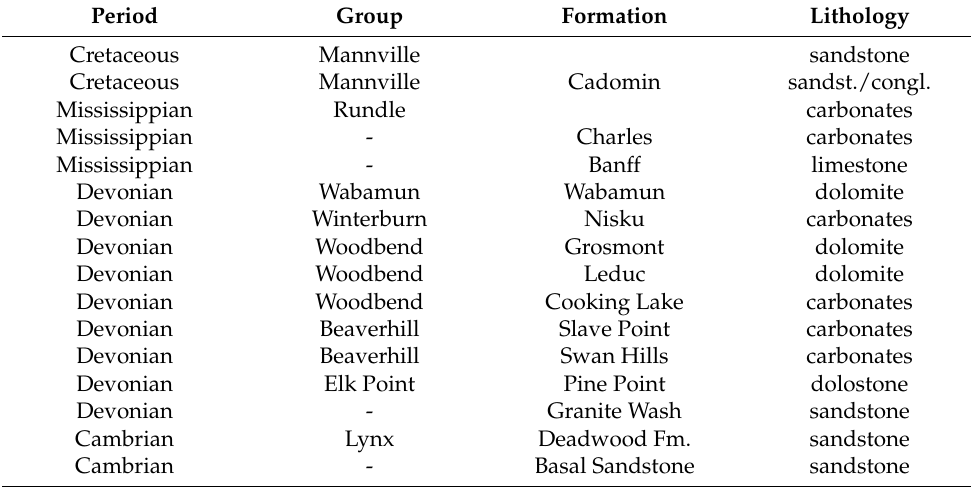
Table 1. Potential geothermal target formations in the WCSB (modified from